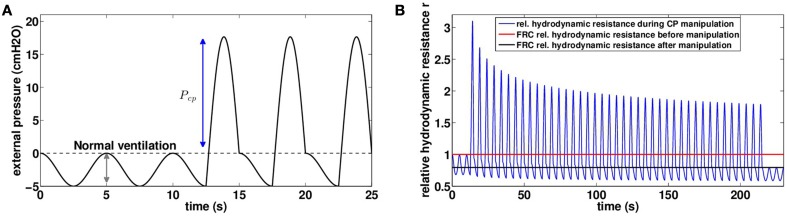
(A) Chest pressure t → Pmanualext(t) used as an input for our model to mimic manual chest physiotherapy. Pressure is assumed homogeneous on the thorax, case with Pcp = 20 cmH2O. (B) Relative hydrodynamic resistance r variations during a manipulation with Pcp = 20 cmH2O (blue). The red line corresponds to FRC relative hydrodynamic resistance before the manipulation (r|t = 0s = 1.00), and the black line corresponds to FRC relative hydrodynamic resistance at the end of the manipulation (r|t = 230s = 0.79).